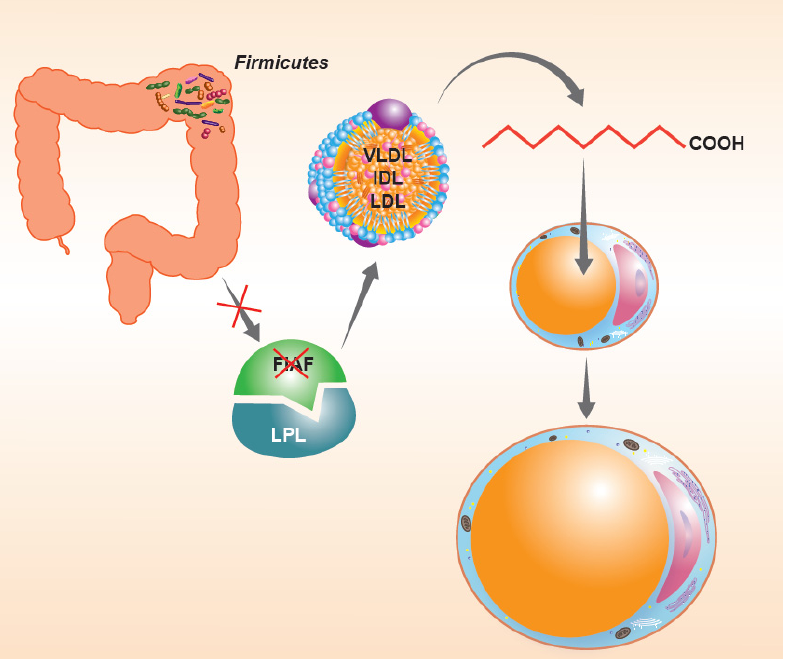
Figure 2. The suppression of intestinal expression of a lipoprotein with inhibitory functions on intestinal lipase (LPL), the so-called fasting-induced adipose factor (FIAF) induced by Firmicutes, would increase the activity of LPL producing an increase in fatty acid extraction capacity from post- prandial fat particles, with an increase in the performance of fat accumulation within the adipocytes.